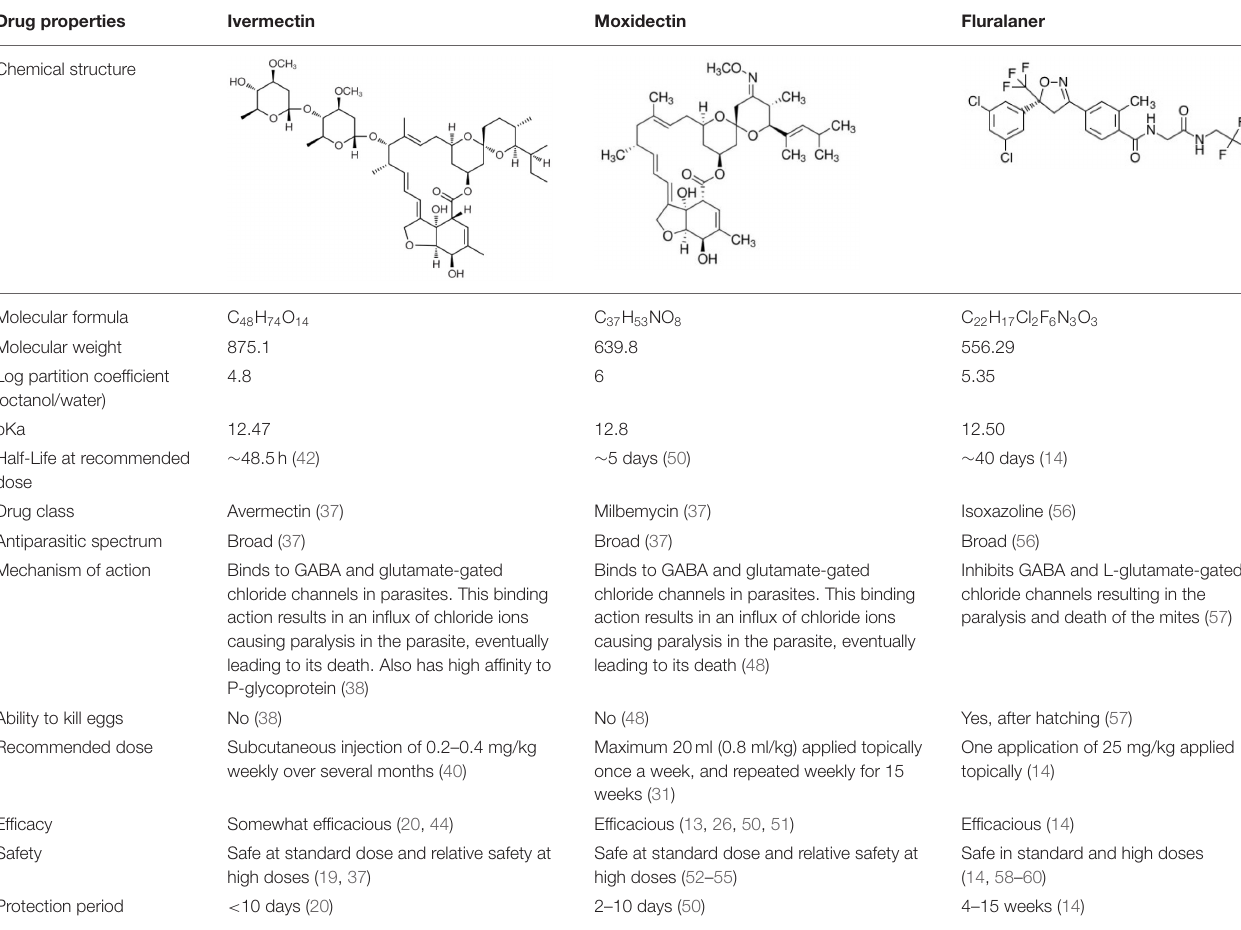
TABLE 1 | Summary of physicochemical, pharmacokinetic and pharmacodynamic parameters for current treatments of sarcoptic mange in wombats. Drug